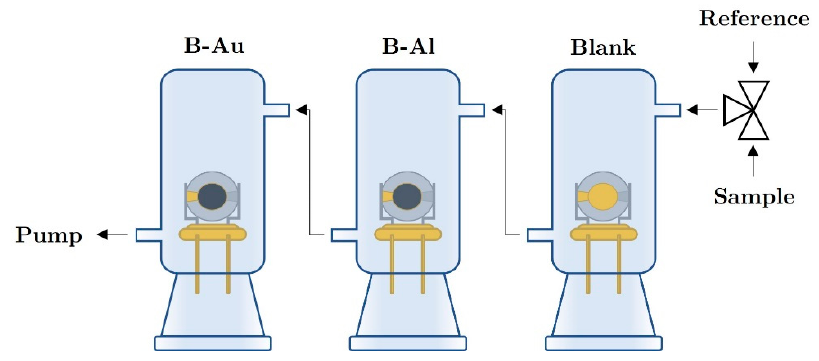
Figure 1. Scheme of the measurement apparatus.